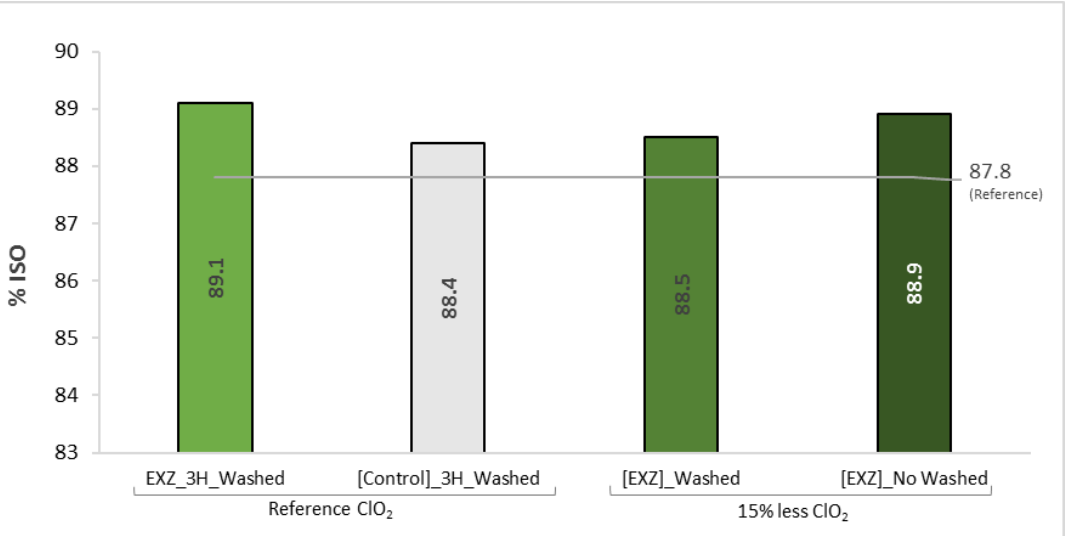
Figure 8. Final brightness of a mixed hardwood pulp obtained after bleaching with the EXZ-bleaching sequence. The reference brightness (87.8% ISO) refers to the pulp usually obtained at mill.